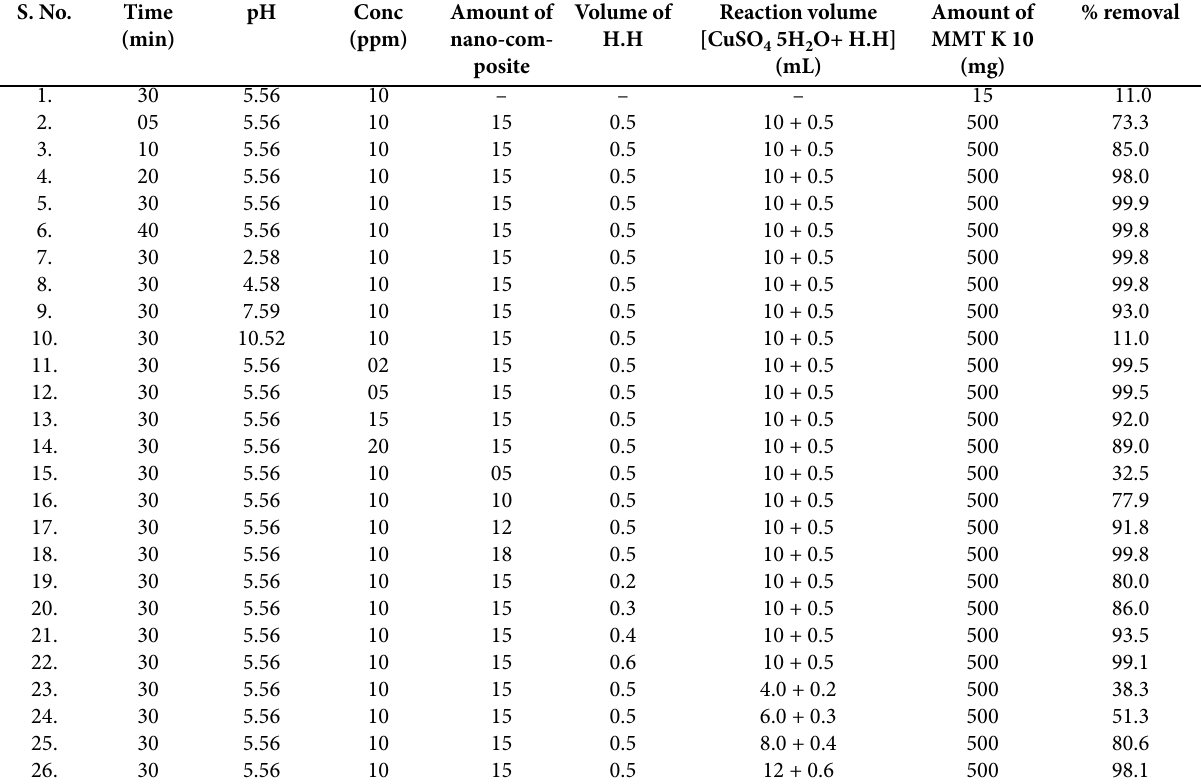
Table 1: Effect of various factors on the removal of Cr(VI) from contaminated water (In all the cases 25.0 mL Cr(VI) solution was taken) S.